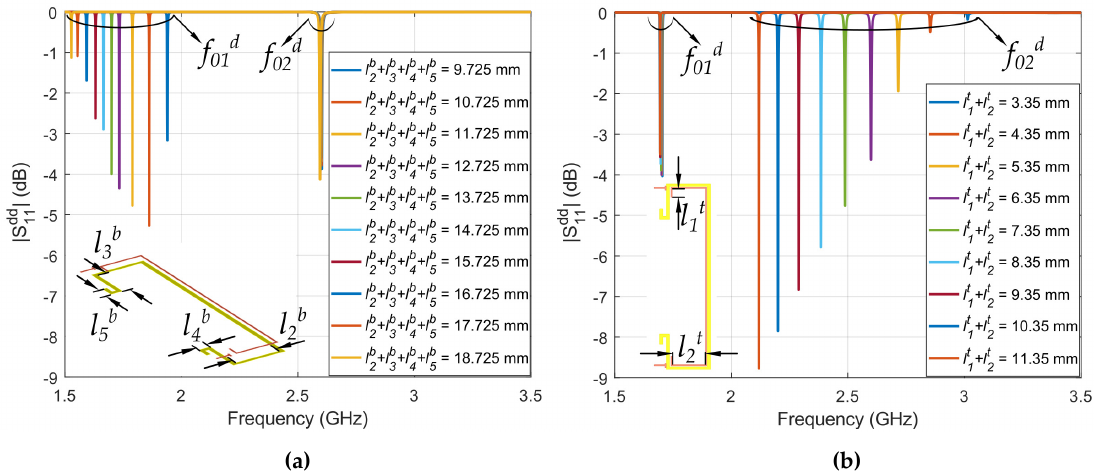
| ) of the structure composed by a couple of top and 11